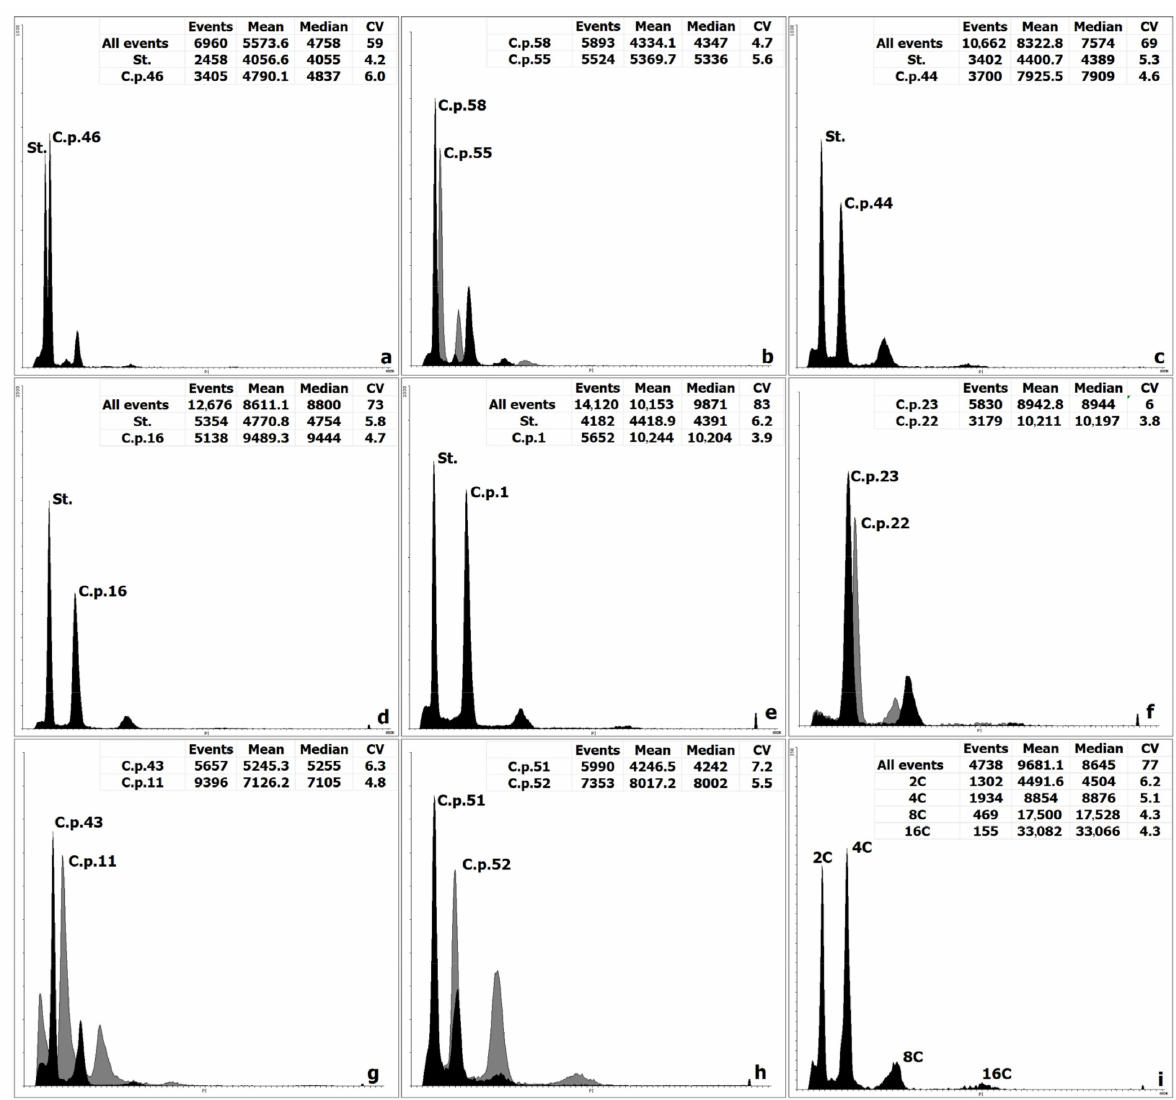
Figure 1. Examples of histograms in cytofluorimetric study of C. pepo (internal standardization): ( a ) standard (Ficus benjamina 2C = 0.90 pg) and diploid sample with cytotype 2C = 1.07 pg; ( b ) com- bined histogram of diploid study with cytotypes 2C = 1.07 pg and 2C = 0.95 pg; ( c ) standard and triploid sample with cytotype 2C = 1.62 pg; ( d ) standard and tetraploid sample with cytotype 2C = 1.84 pg; ( e ) standard and tetraploid sample with cytotype 2C = 2.08 pg; ( f ) pooled histogram of tetraploid study with cytotypes 2C = 1.84 pg and 2C = 2.08 pg; ( g ) pooled histogram of diploid and triploid studies with cytotypes 2C = 1.08 pg and 2C = 1.50 pg; ( h ) pooled histogram of tetraploid and octaploid studies with cytotypes 2C = 2.08 pg and 2C = 3.61 pg; ( i ) example of